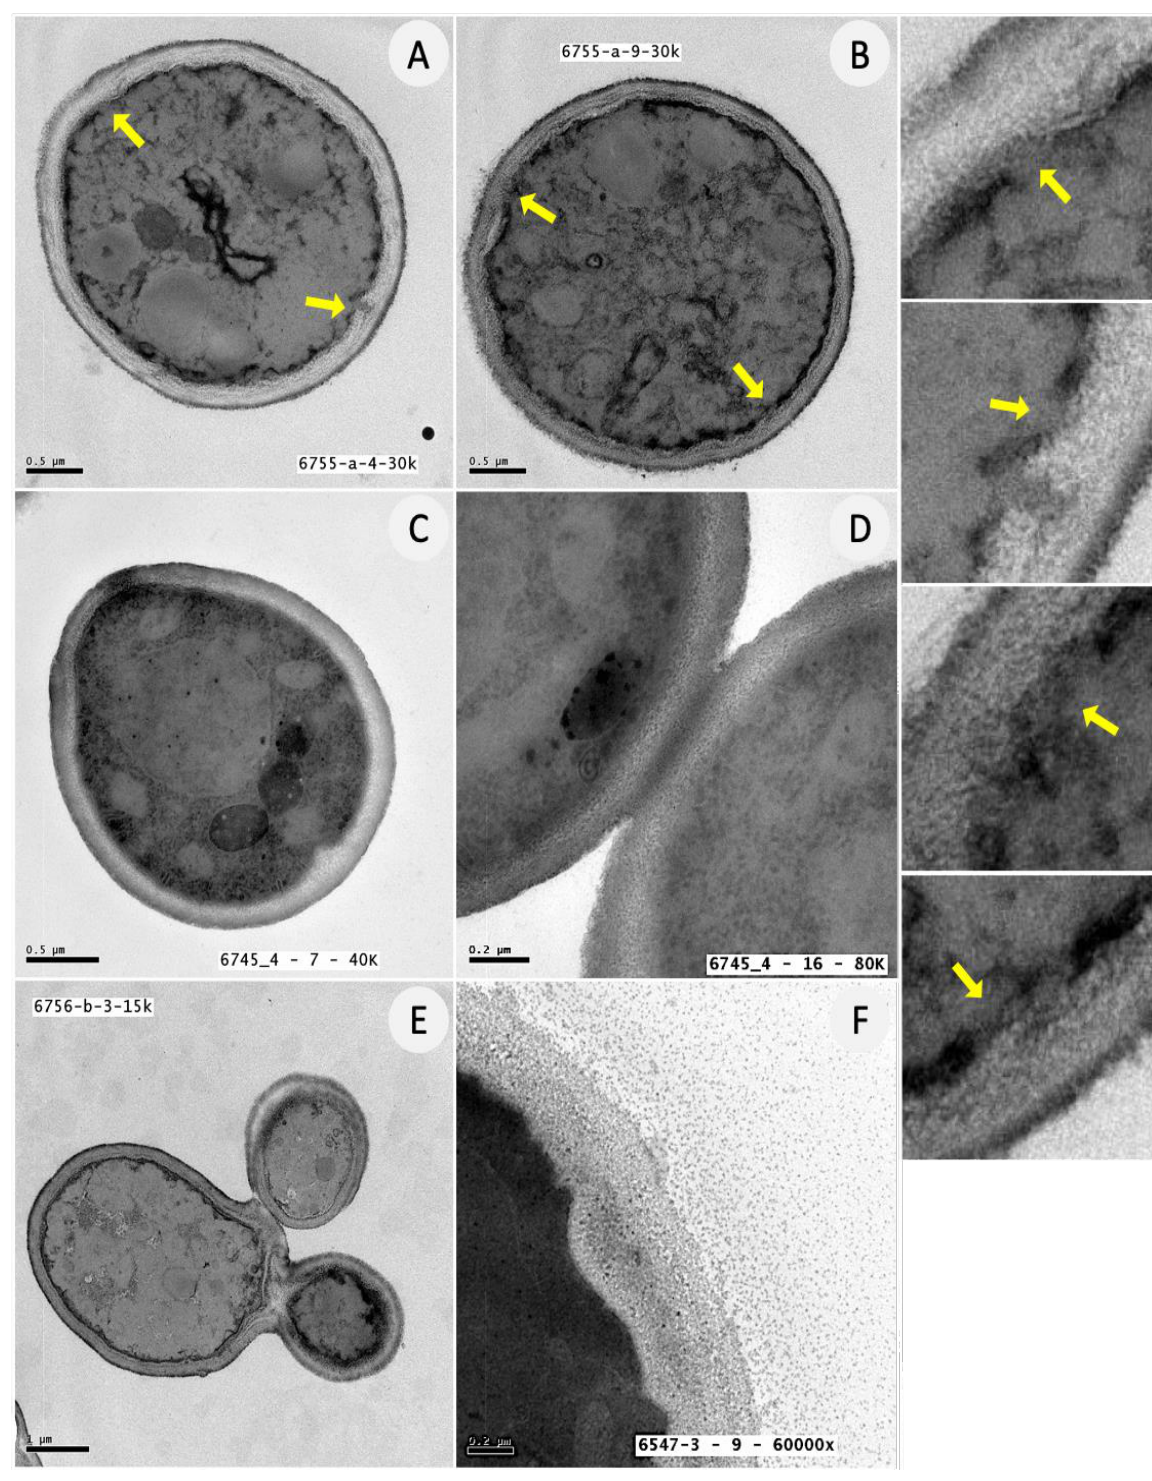
Figure 6. Ultrastructural features of C. albicans cells after ATRA treatment by TEM analysis. ( A – F ) Representative images of C. albicans cells treated with ATRA at different concentrations for 24 h. ( A,B ) ATRA 300 µg/mL; ( C,D ) ATRA 150 µg/mL; ( E,F ) ATRA 37.5 µg/mL. ( A–D ) TEM images show isolated and metabolically inactive Candida yeasts, incapable of replicating in budding daughter cells and growing in hyphal forms; no extracellular granular material was detected around Candida cells; ( A,B ) evidence of cell damage with discontinuities of the plasma membrane (yellow arrows); ( E,F ) Candida cells replicating as budding yeasts and releasing extracellular granules.